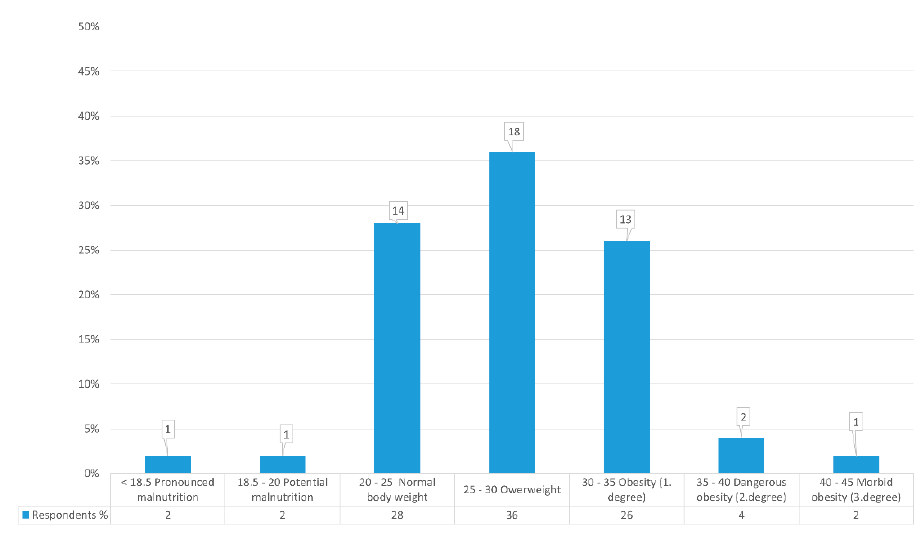
Figure 1. Distribution of users according to body mass index (BMI) shown in absolute and relative terms.